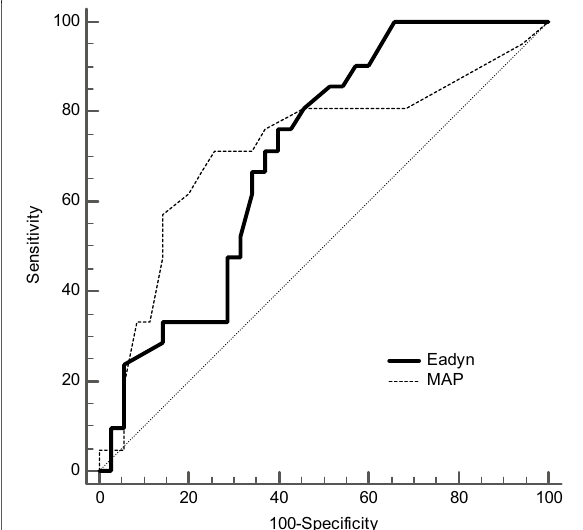
Fig. 4 Receiver‑operating characteristic curves showing the ability of baseline dynamic arterial elastance (Eadyn) and baseline mean arterial pressure (MAP) to predict an increase in MAP volume